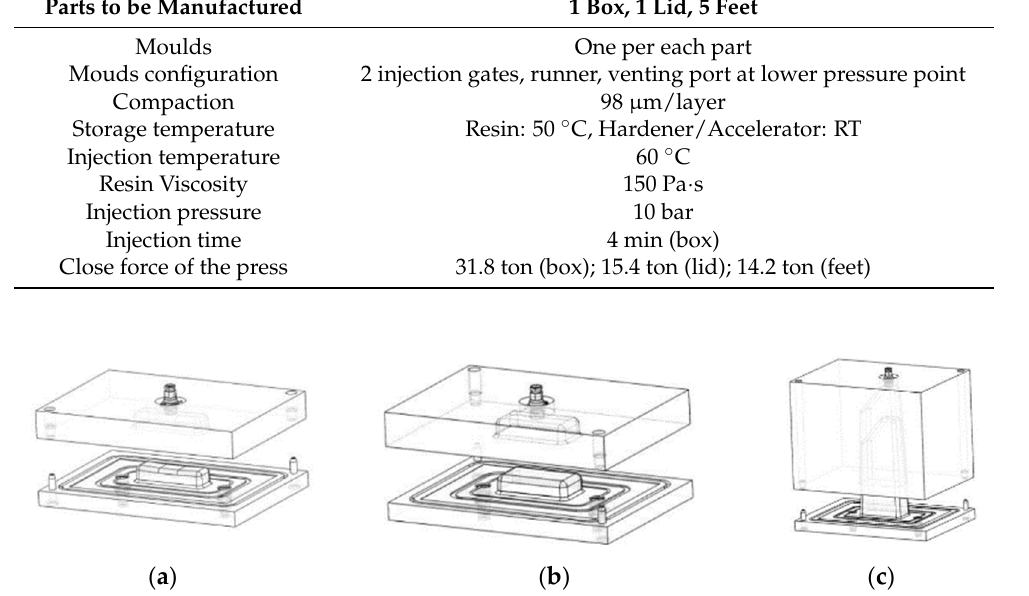
Figure 18. 3D models of the moulds for CFRP breadboard components manufacturing ( a ) feet ( b ) lid ( c ) box.